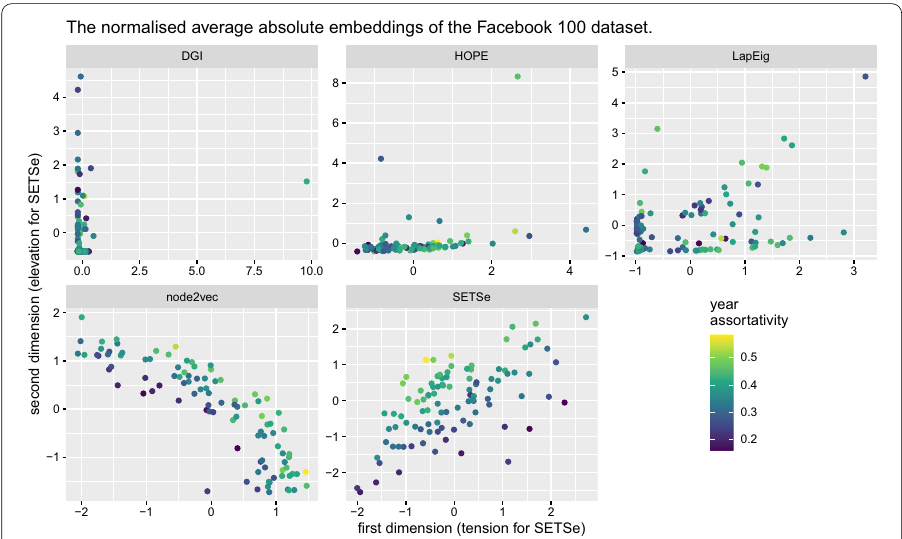
Fig. 8 There is a clear relationship between the SETSe embeddings and year assortativity; however, the pattern is dependent on elevation and tension. SETSe finds large differences between networks with very similar